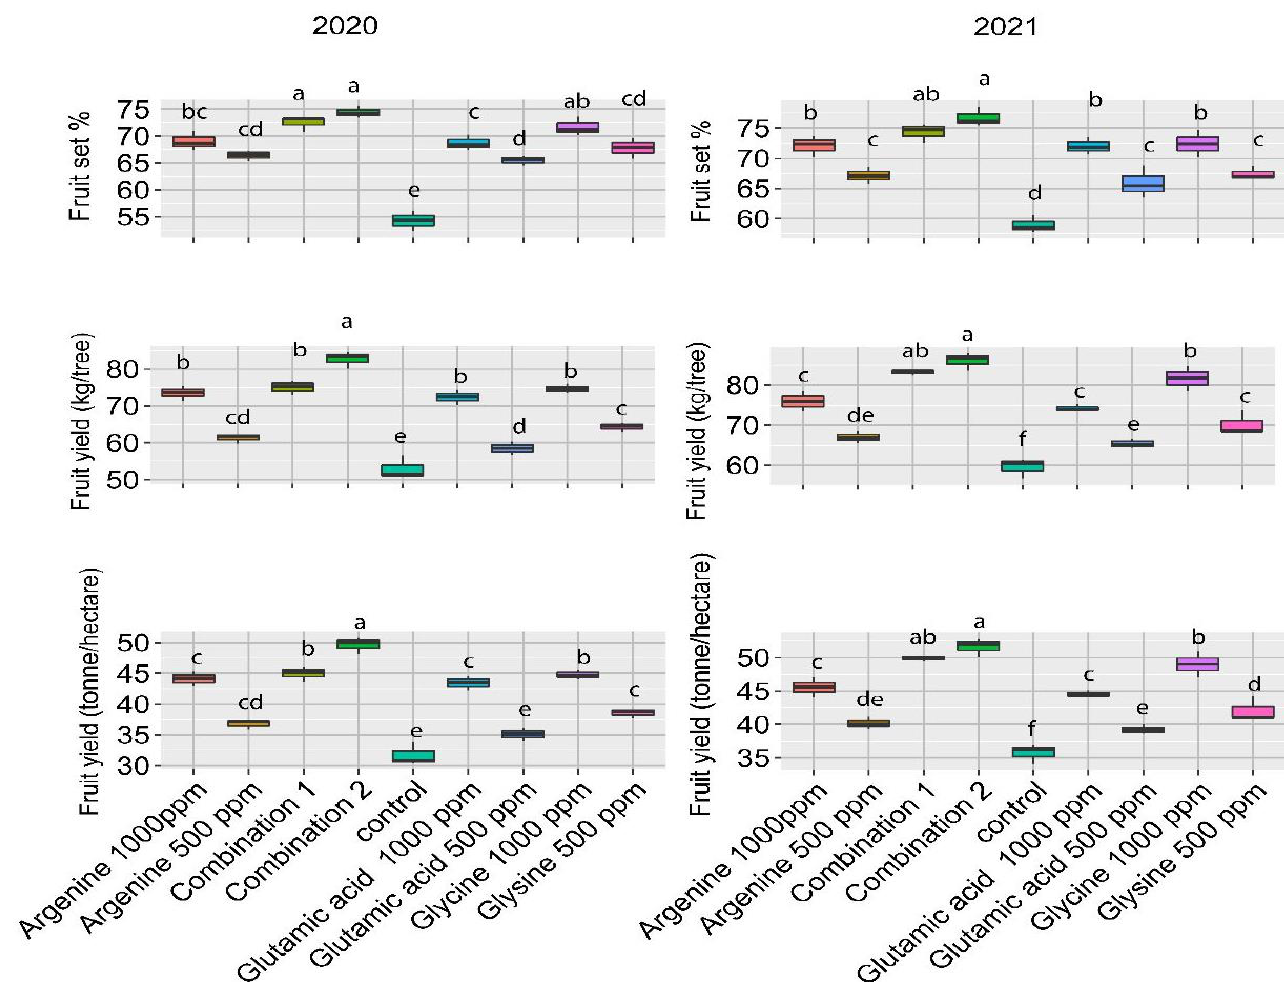
Figure 1. The influence of glutamic acid, arginine, and glycine amino acids on fruit set percentages and fruit yield in kg per tree and ton per hectare of guava during the 2020 and 2021 seasons. Treatments that have the same letters have no significant differences between them.